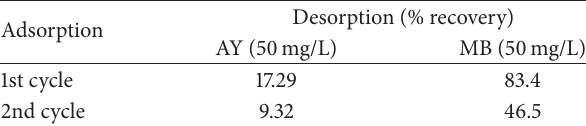
Table 6: Desorption of dyes from DNPH- 𝛾